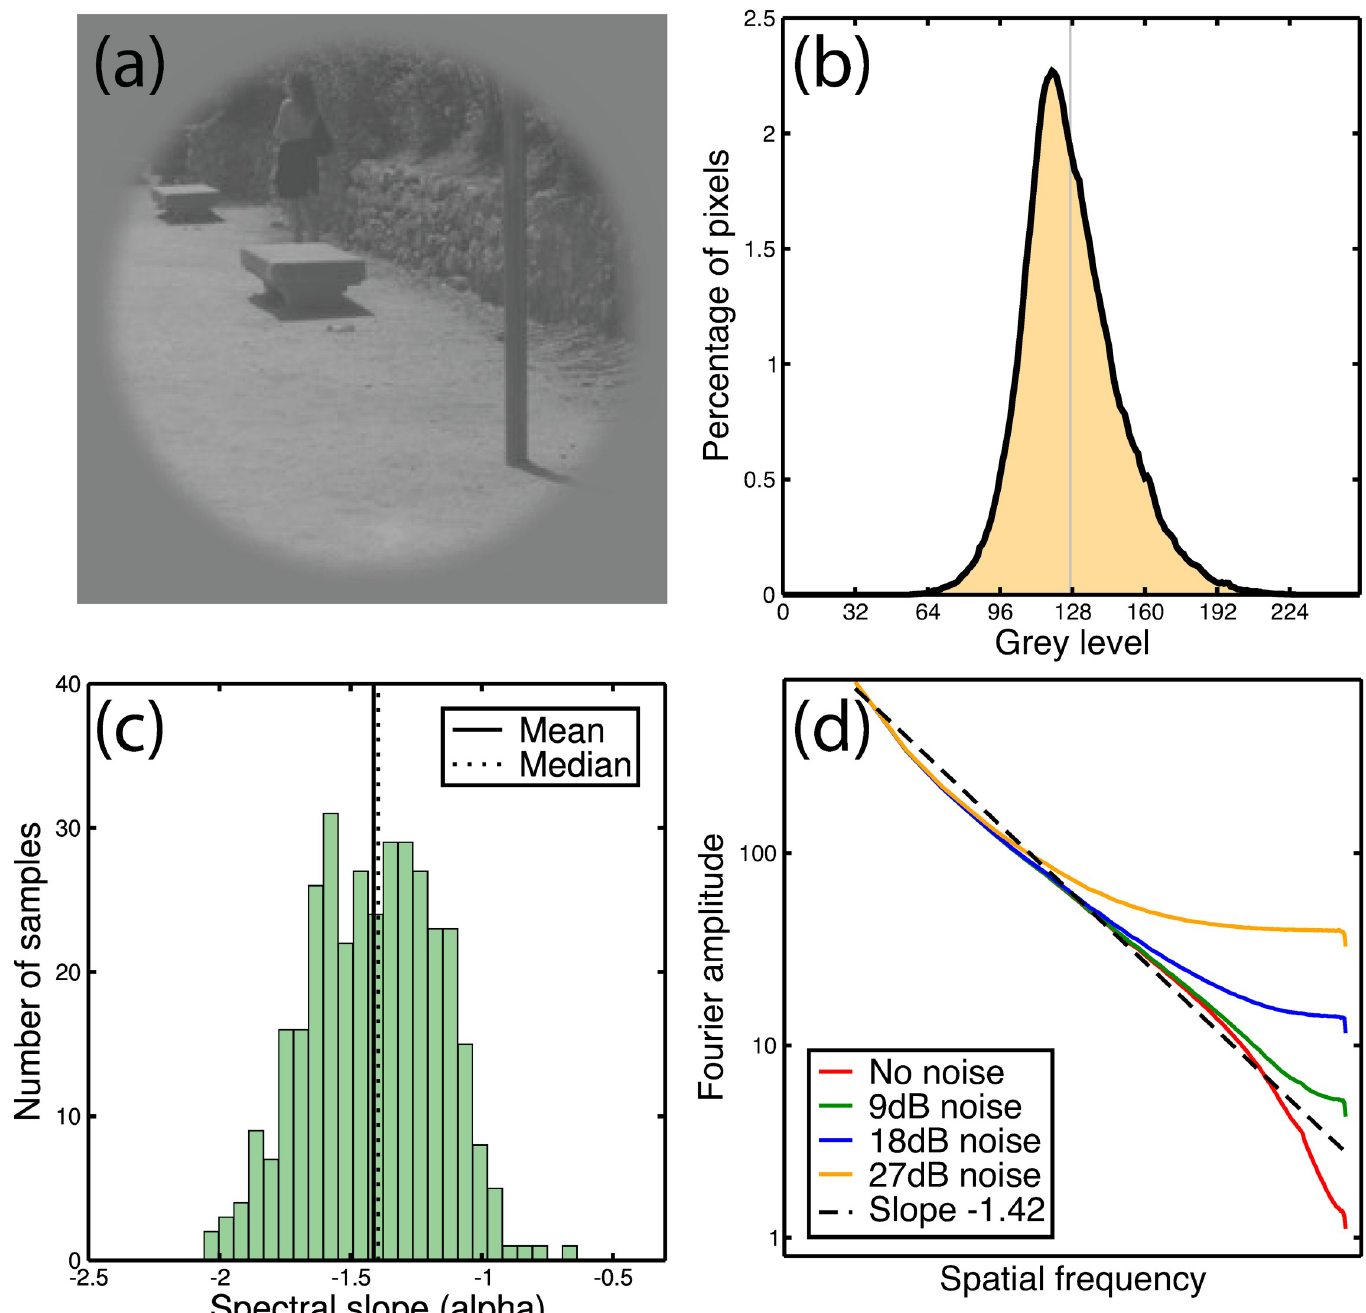
Fig 4. Example image, and statistics of image set. Panel (a) is an example windowed image used in the experiment, shown here with no added noise. Panel (b) shows the grey level histogram for the DC-balanced image set (308 images, each 256x256 pixels). The distribution shows slight positive skew, so the modal grey level (119) is below the mean (128). Panel (c) is a histogram showing the frequency of different spectral slopes in the image set. The mean and median alpha values are around -1.45. In panel (d), the effect on the spectral slope of adding white noise is shown. Values are averaged across all 308 images in the data set. Increasing amounts of white noise distort the approximately linear (on log-log axes) slope obtained with no added noise (red curve). With large amounts of white noise, the spectrum is flat (a slope of 0) over a substantial portion of the frequency range (e.g., for noise of 27dB, orange curve).